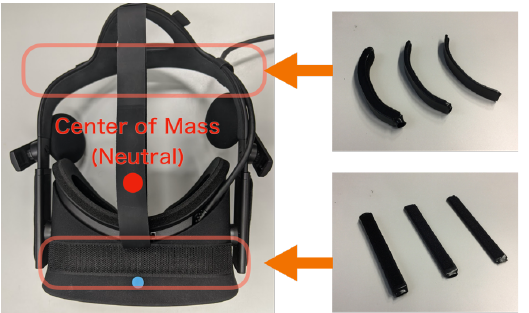
Figure 1. Diagram of the Oculus Rift CV1 with hook-and-loop fasteners and lead weights